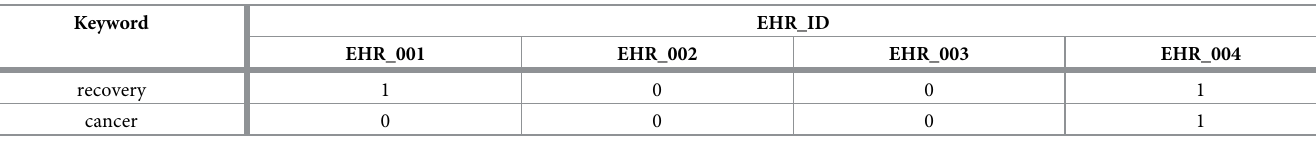
Table 2. Illustration of the bitmap index.